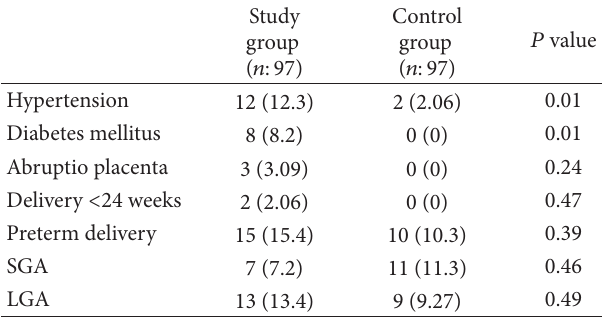
T 2: Antenatal complications.